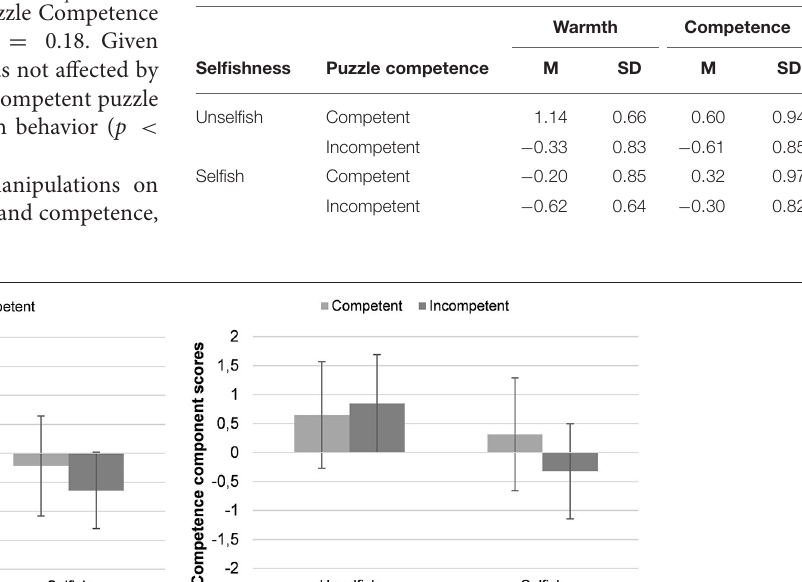
TABLE 3 | Means and standard deviations for warmth and competence.